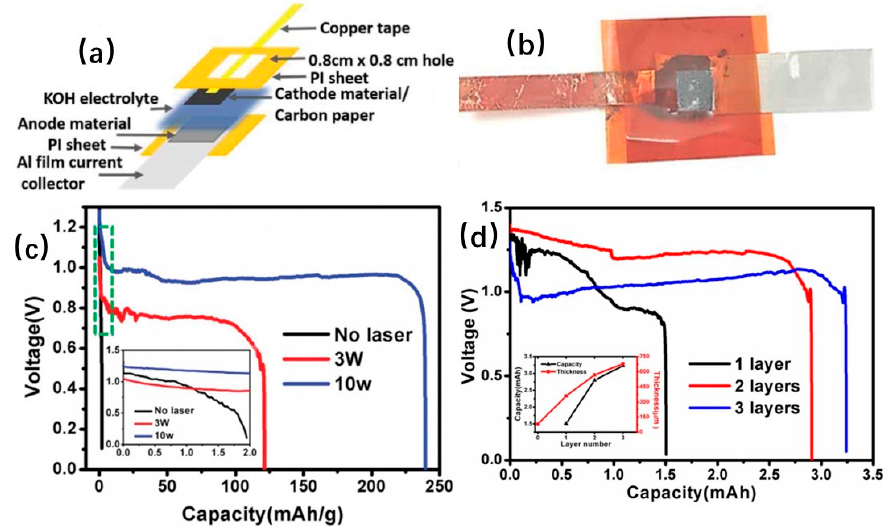
Figure 17. ( a ) Schematic of aluminum–air batteries (AAB) working principle, ( b ) Photo of a packaged battery cell, ( c ) The first cycle discharge capacity with different laser sintering powers. ( d ) Discharge capacity for 3D printed anode and relationship between anode thickness and capacity [3] (Copyright © 2018, Electrochemical Society).